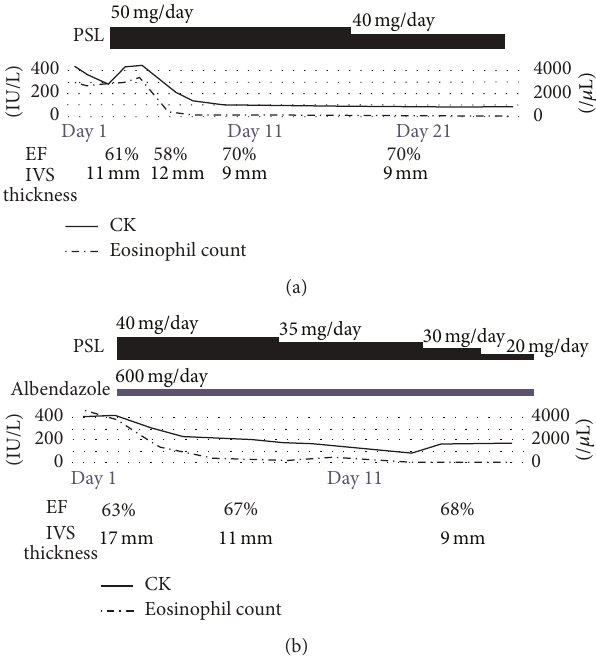
Figure 2: Clinical courses of the cases. (a) Case 1. (b) Case 2. In both cases, after starting prednisolone, CK and eosinophil count immediately came into the normal range, and ejection fraction and wall thickness also recovered. CK, creatinine phosphokinase; EF, ejection fraction; IVS, interventricular septum thickness; PSL,